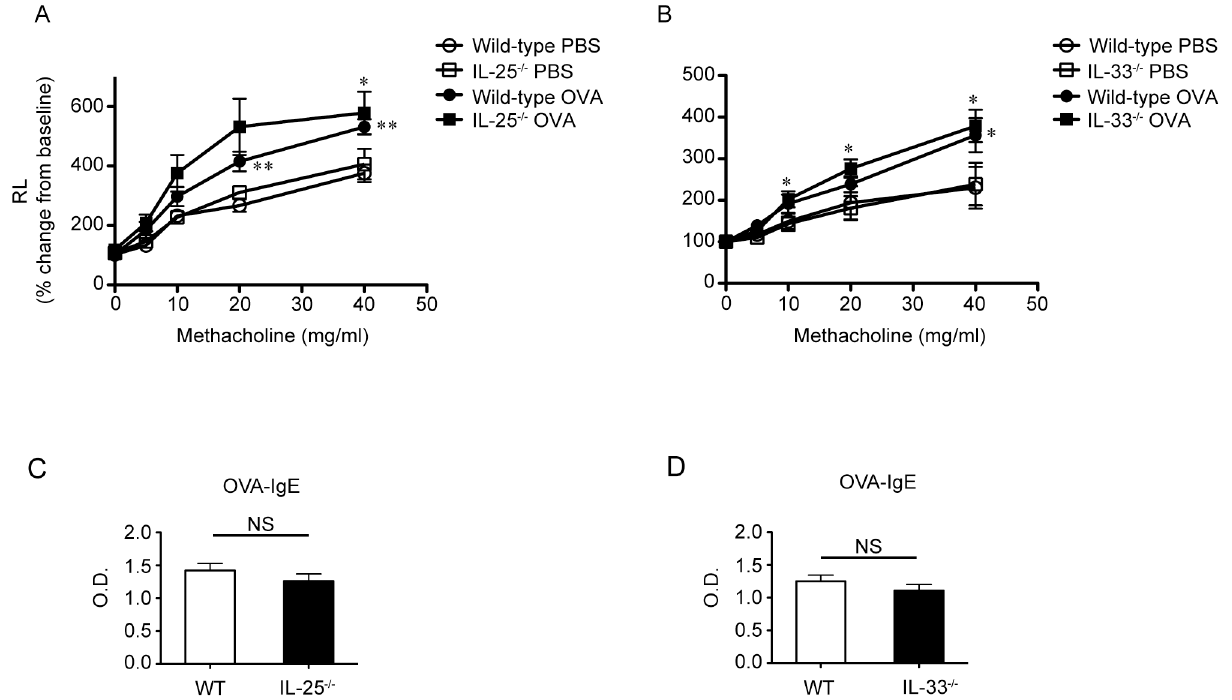
Fig 6. IL-25 and IL-33 are not required for airway hyperresponsiveness after the last intranasal OVA challenge in mice sensitized epicutaneously (EC) with OVA. Twenty-four hours after the last inhalation of OVA or PBS, mice sensitized EC with OVA were monitored for pulmonary resistance in response to methacholine. (A) Wild-type (WT) (PBS, n = 7; OVA, n = 7) and IL-25 -/- mice (PBS, n = 7; OVA, n = 7). (B) WT (PBS, n = 5; OVA, n = 8) and IL- 33 -/- mice (PBS, n = 5; OVA, n = 12). (C, D) The levels of OVA-specific IgE in sera from mice after intranasal challenge were determined by ELISA. Data show the mean + SEM. * P < 0.05 and ** P < 0.01 vs. the corresponding values for PBS-treated mice (A, B). NS (not significant) vs. the indicated group (WT vs. IL- 25 -/- , or WT vs. IL-33 -/- )(C,